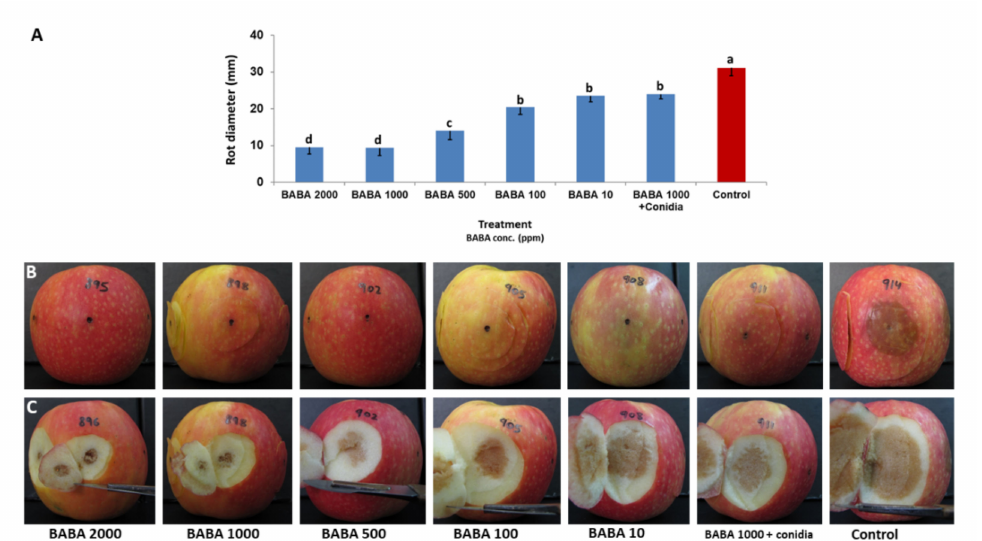
Figure 4. ( A ) Resistance against AFR caused by A. alternata f. sp. mali induced in detached apple fruits by BABA of various concentrations. In treatment ‘BABA 1000 + conidia’, a mixture of BABA with conidial suspension was used for inoculation. Inoculated fruits were incubated in a moist chamber at 25 ◦ C for 13 days. The mean values represent fruit rot diameter produced in each inoculation site of each of three fruits per concentration. Bars represent the standard error of the mean. Different letters on columns indicate significant differences between treatments ( p < 0.05, Fisher’s LSD K-ratio t -test). ( B ) Photos of rot developed on skin of fruits treated with BABA at various concentrations, and untreated control fruit. ( C ) Photos of rot developed in the mesoderm of fruits treated with BABA of various concentrations. Control = untreated inoculated